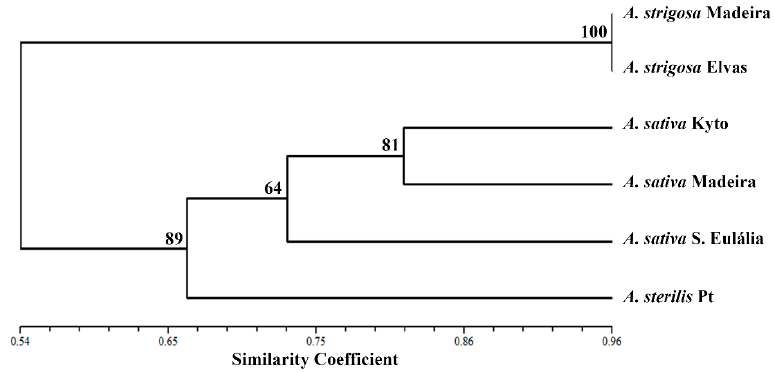
Figure 8. Dendogram based on concatenated centromeric, IRAP and REMAP banding profiles. DICE similarity index [36] and UPGMA clustering mode were used. Cophenetic correlation coefficient of 0.996.